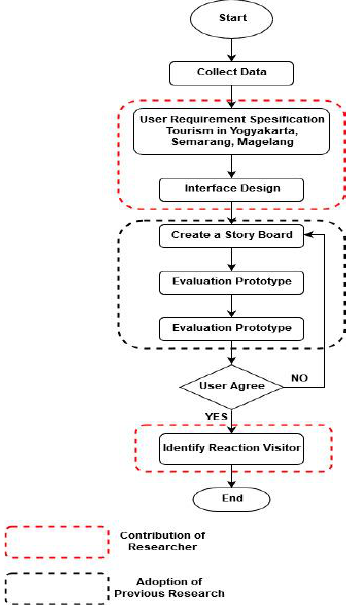
Fig. 1. Flowchart